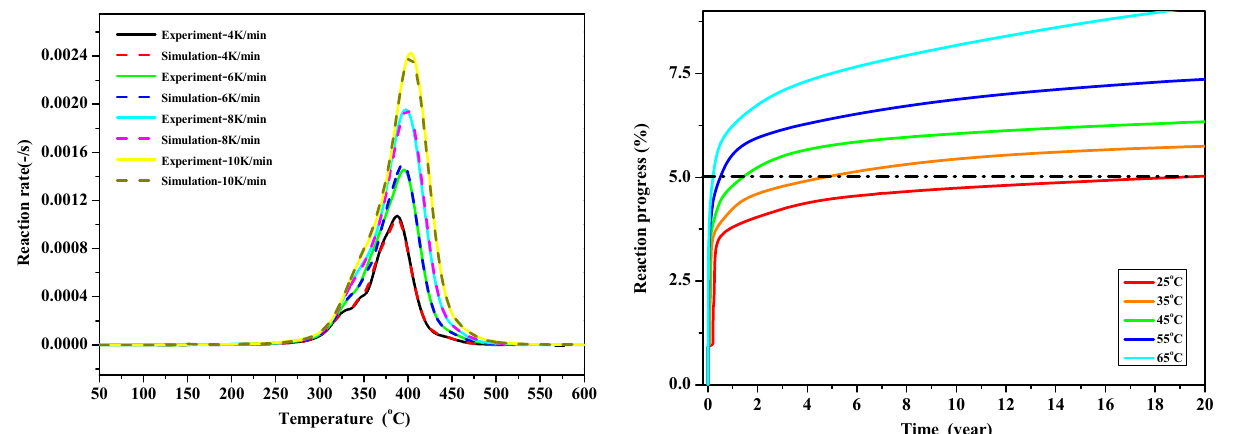
Figure 6: Reaction rate of polyacrylate PSA at di ff erent heating rate.